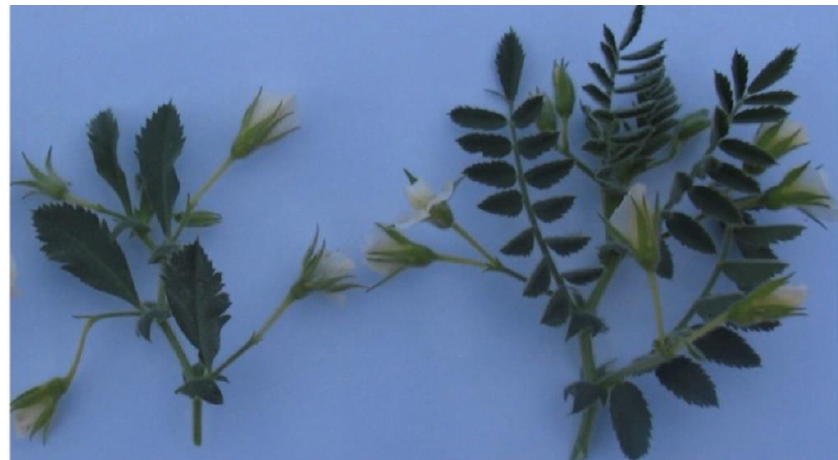
Figure 1. Morphological traits of parents, Sierra (single-podded and unifoliolate leaf, left side) and CA 2969 (double-podded and imparipinnate leaf, right side).